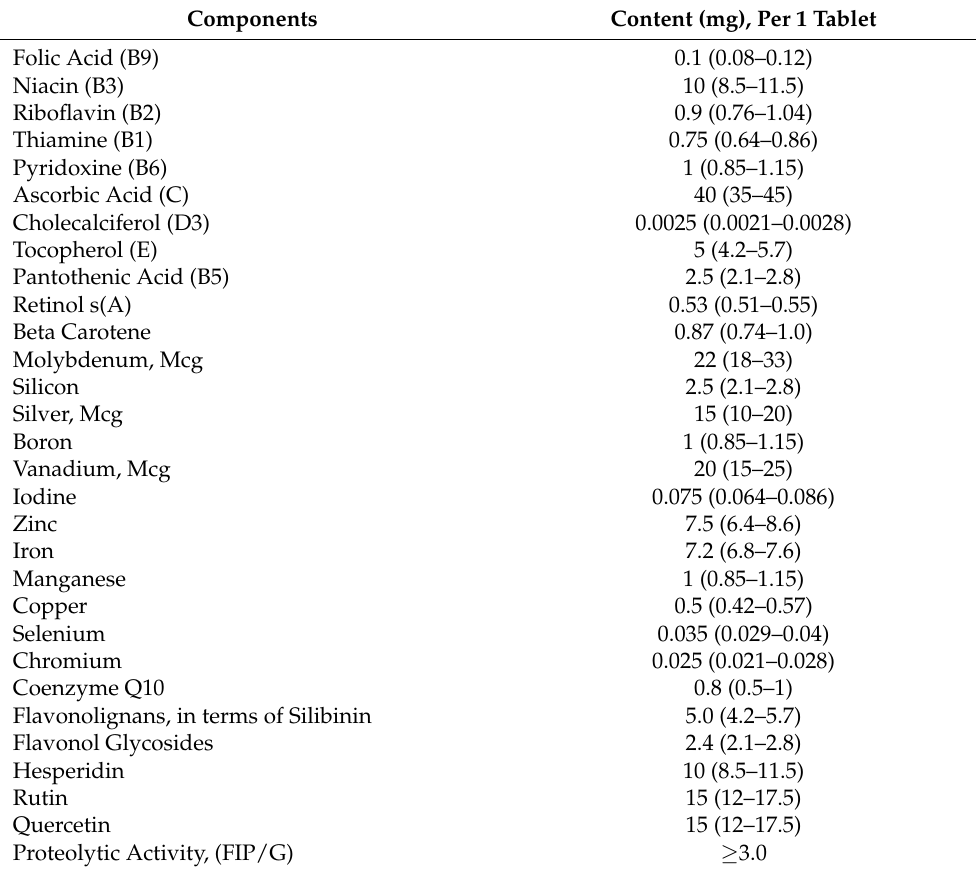
Table 3. The nutritional value of the dietary